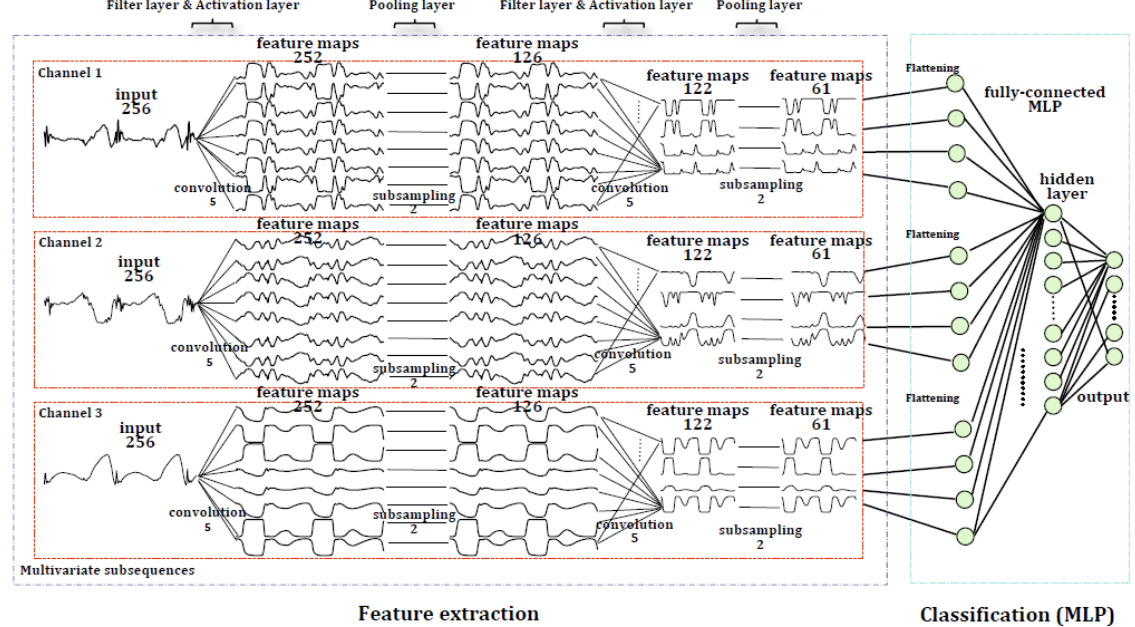
Figure 1. A two-stage MC-DCNN architecture for activity classification. This architecture consists of a three-channel input, two filter layers, two pooling layers, and two fully connected layers (after Zheng et al.,